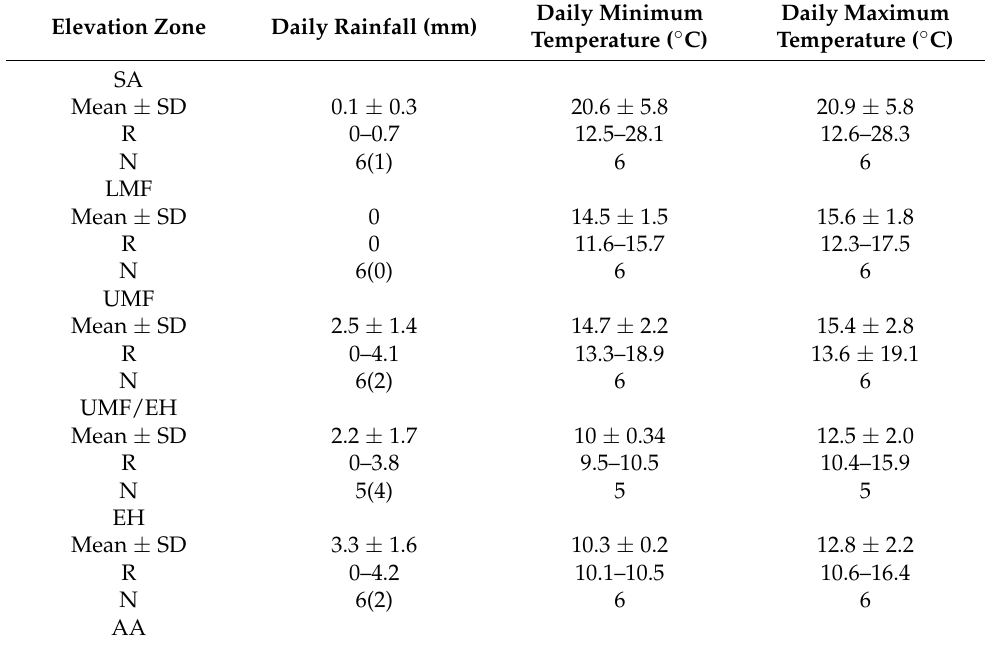
Table A2. Climate data registered at each elevational site on Mount Meru in February–November 2021 during the small mammal survey. Totals presented as mean and standard deviation (Mean ± SD), range(R) and number of days measured (N). The rainfall samples are expressed as the number of days measured and number of days with rain (in